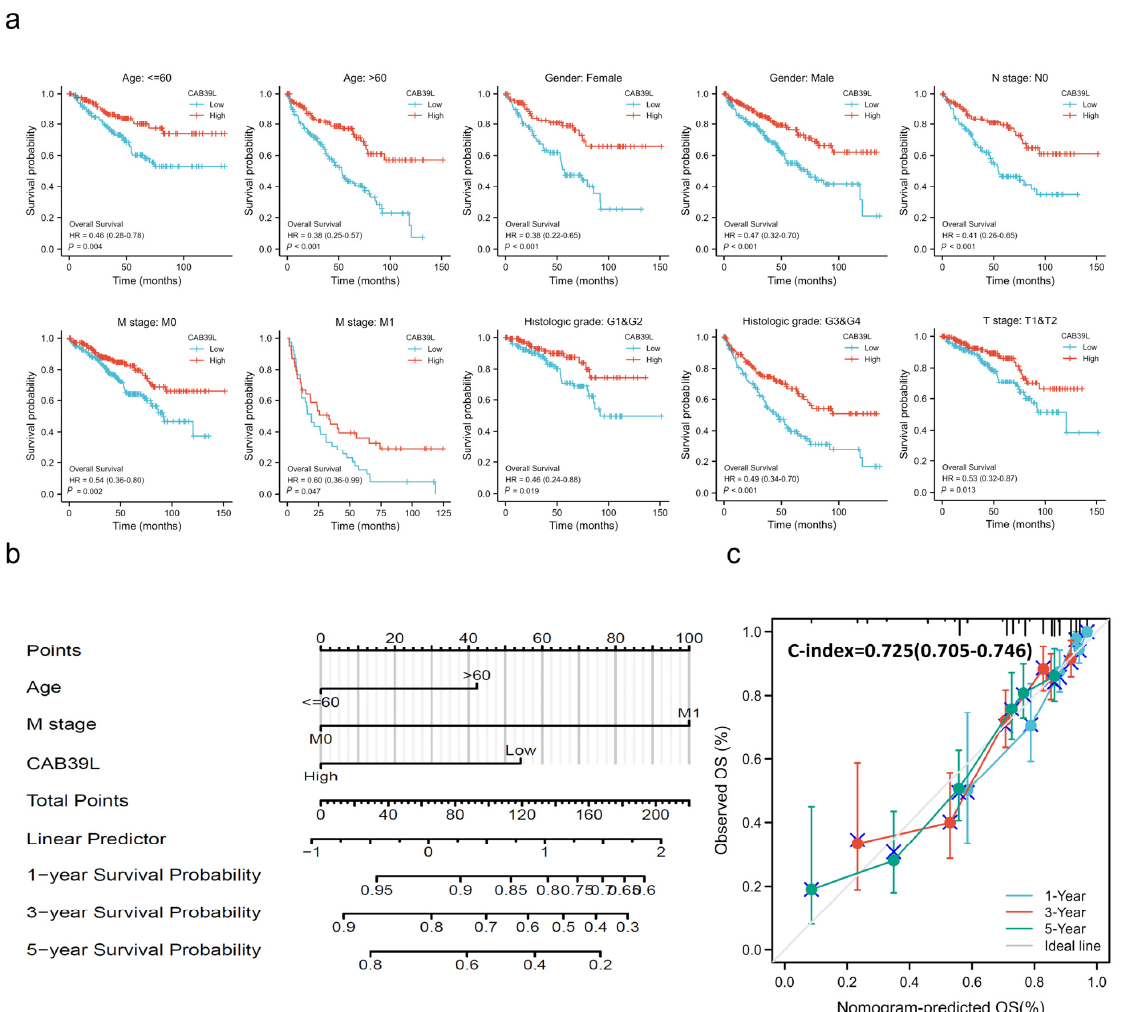
Figure 5. Prognostic value of CAB39L in subgroups of KIRC patients and construction and validation of the nomogram based on CAB39L mRNA expression. ( a ) The relationship between CAB39L expression and OS in different subgroups, including age ≤ 60, age > 60, female, male, N0 stage, M0 stage, M1 stage, T1 and T2 stage, G1 and G2 stage, and G3 and G4 stage. ( b ) The OS of KIRC patients at 1, 3, and 5 years was predicted by the nomogram model. ( c ) The efficiency of the nomogram for OS was validated by calibration curves.